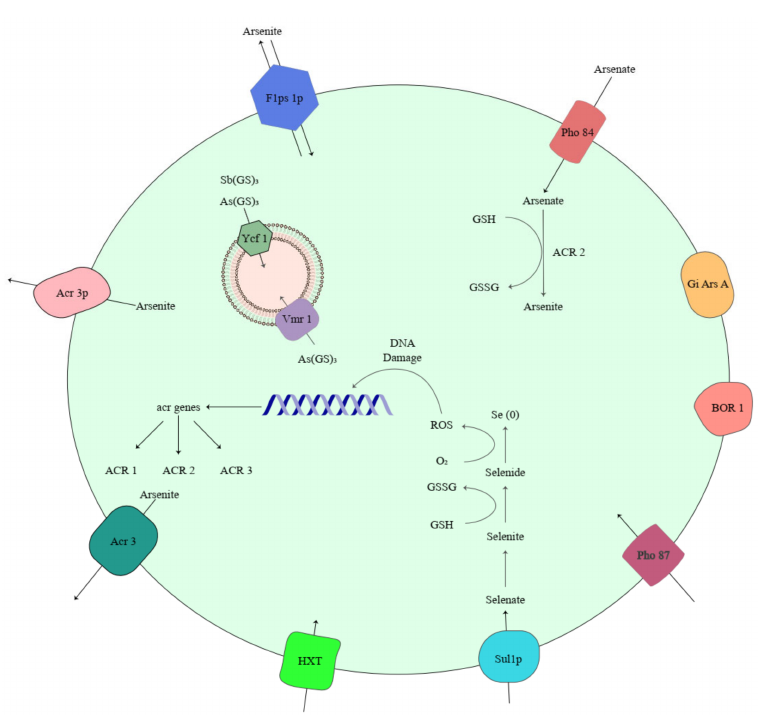
Figure 3. Metalloid transporter and protein involved in metalloid uptake and detoxification in